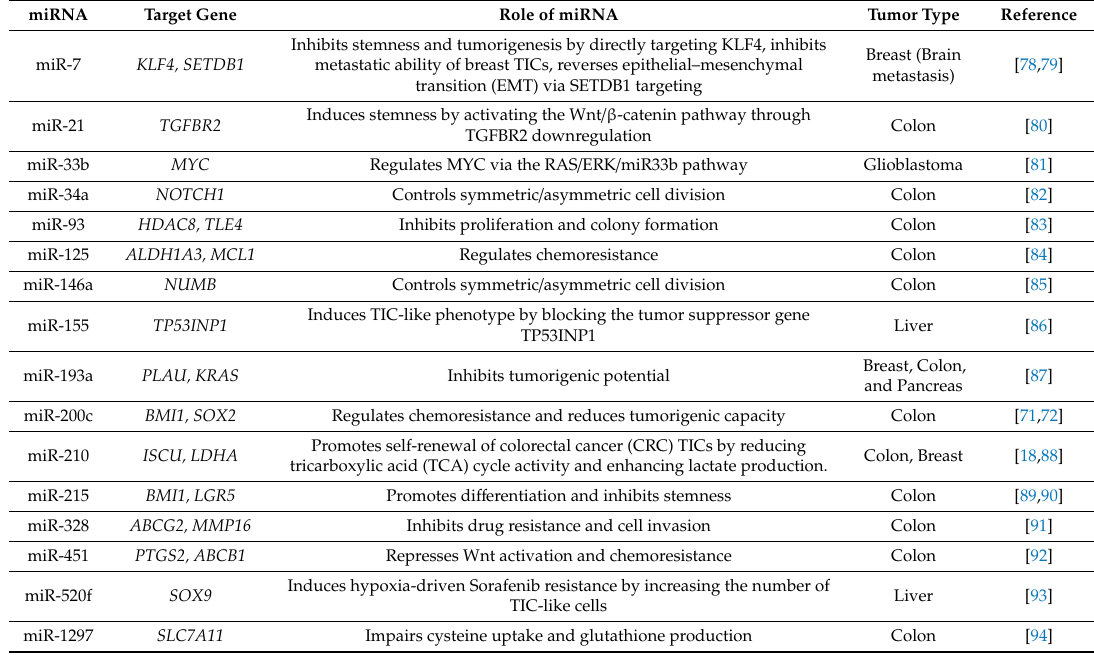
Table 1. Tumor-initiating cells (TIC)-associated microRNAs (miRNAs) and their function. miRNA Target Gene Role of